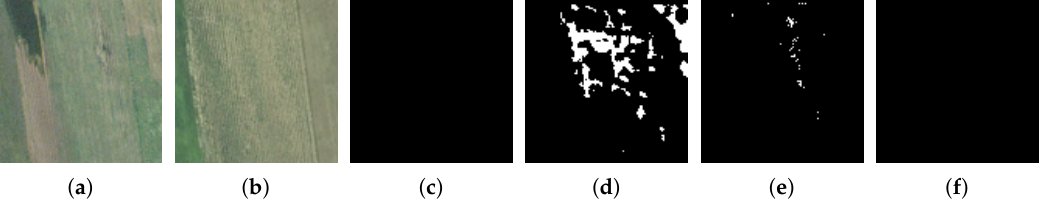
Figure 16. Patch-based change maps generated from different methods on TISZADOB/3. ( a ) Image patch one. ( b ) Image patch two. ( c ) Grounth truth ( d ) Result using FC-Siam-diff. ( e ) Result using the pseudo-siamese capsule network. ( f ) Result using the change capsule